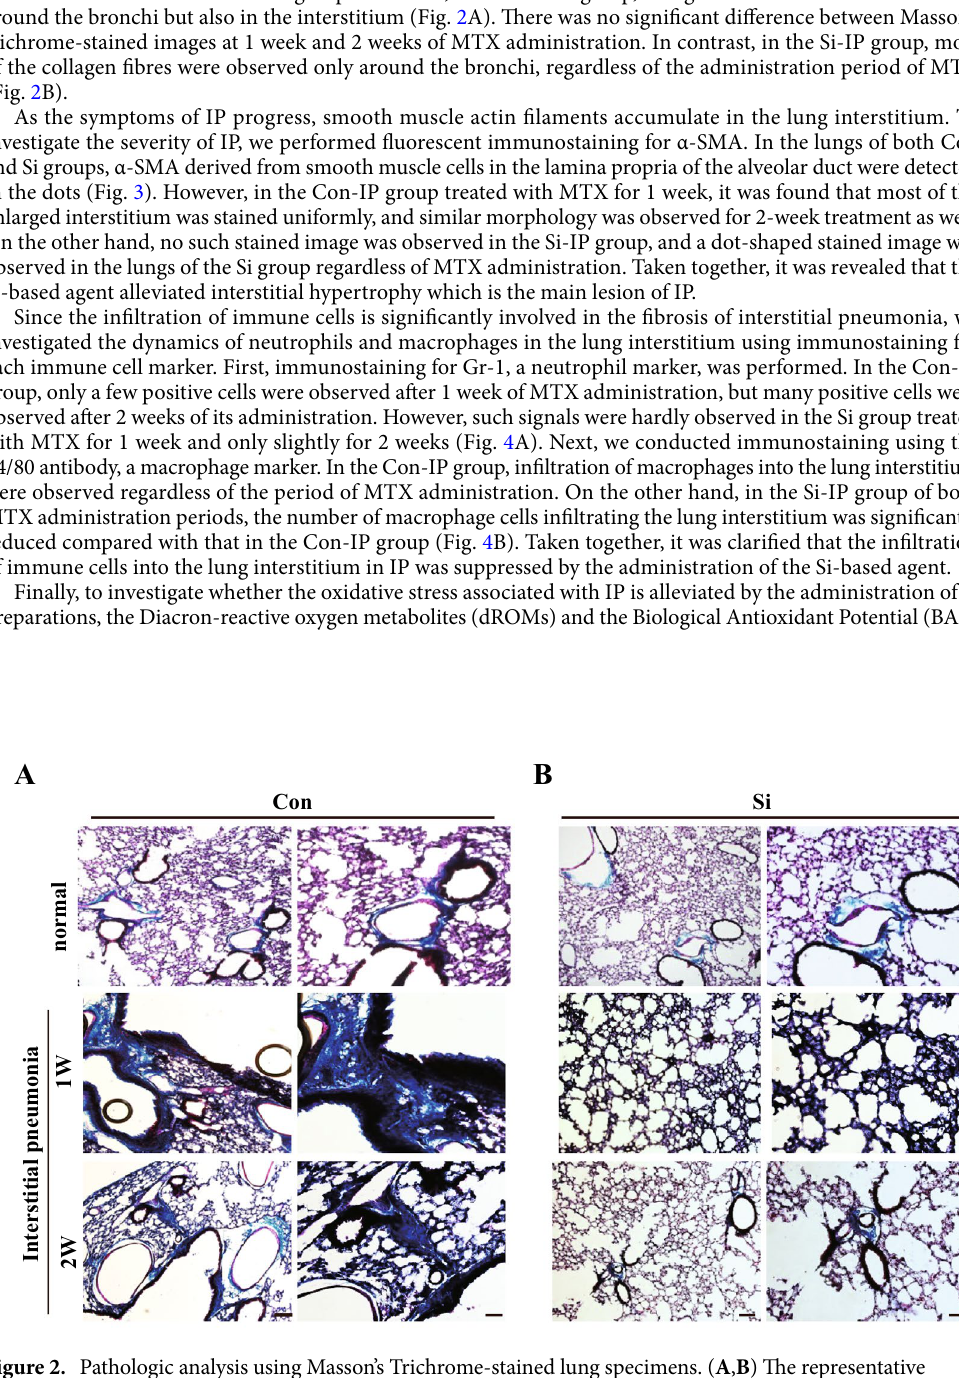
Figure 2. Pathologic analysis using Masson’s Trichrome-stained lung specimens. ( A , B ) The representative microphotographs of the lung in the normal mice (upper panel) and IP mouse models treated with MTX for 1 week (middle panel) and 2 weeks (bottom panel). ( A ) Con group or Con-IP group ( B ) Si group or Si-IP group. Scale bar 100 µm ( A , B : left); 50 µm ( A , B :